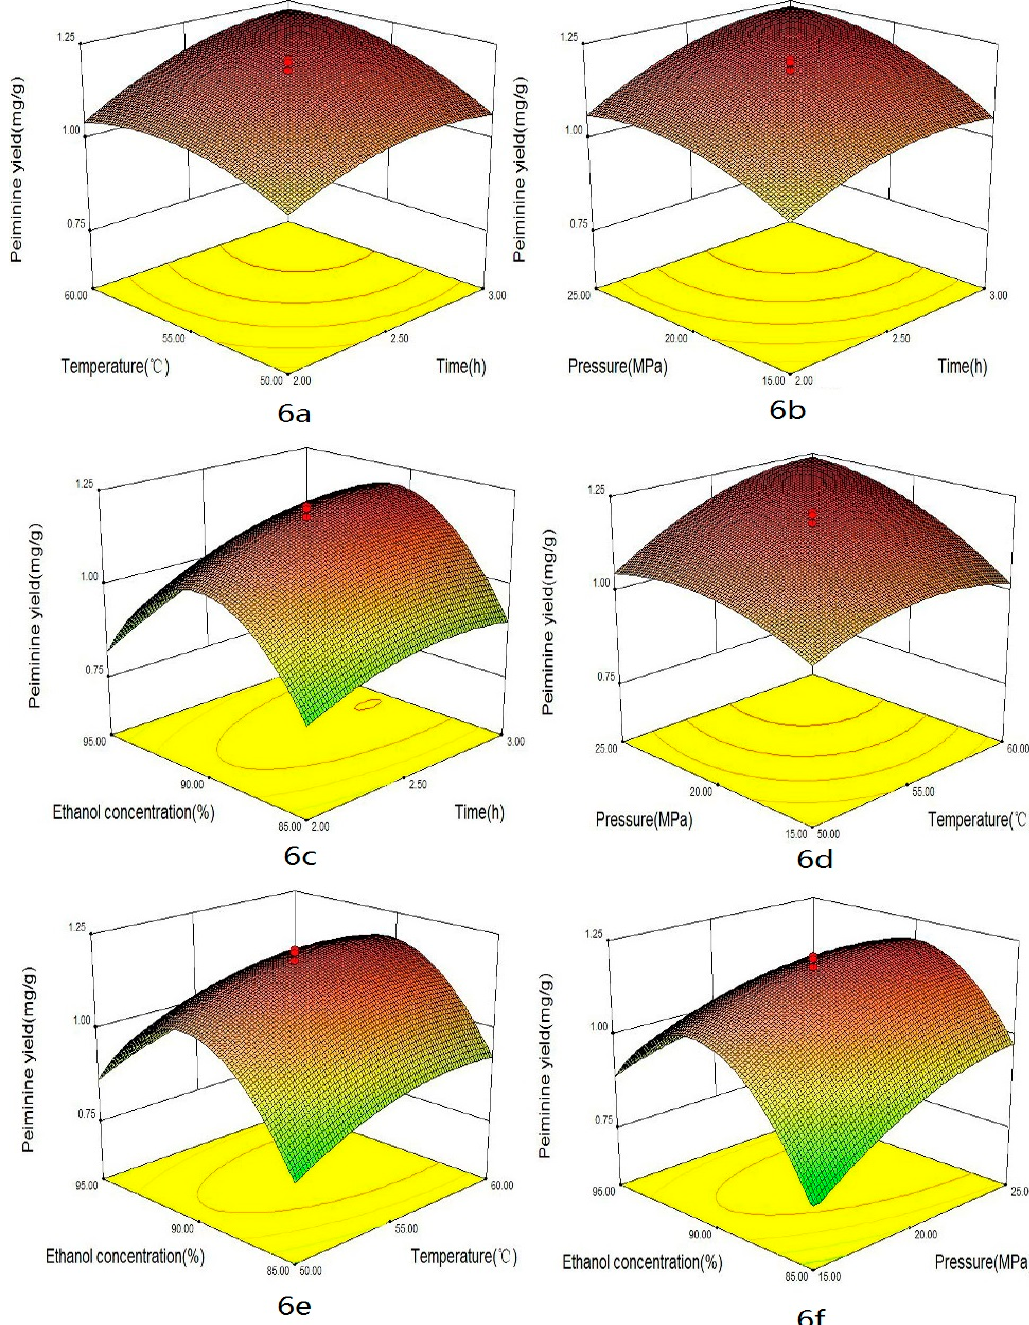
Figure 6. Response surface plots of peiminine yields showing: ( a ) the effect of time and temperature at constant pressure (20 MPa) and ethanol concentration (90%); ( b ) the effect of time and pressure at constant temperature (55 °C) and ethanol concentration (90%); ( c ) the effect of time and ethanol concentration at constant temperature (55 °C) and pressure (20 MPa); ( d ) the effect of temperature and pressure at constant time (2.5 h) and ethanol concentration (90%); ( e ) the effect of temperature and ethanol concentration at constant time (2.5 h) and pressure (20 MPa); and ( f ) the effect of pressure and ethanol concentration at constant time (2.5 h) and temperature (55 °C).